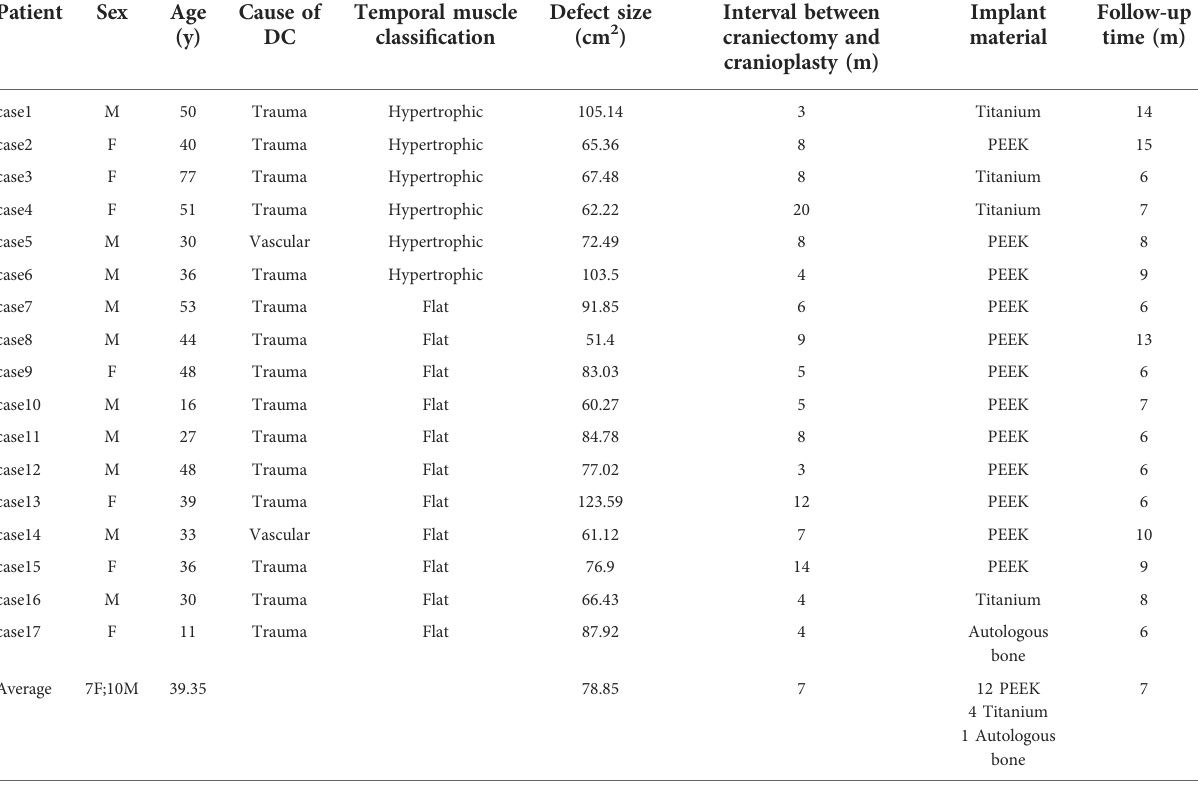
TABLE 1 Summary of patient demographics and classi fi cations of the temporal muscle. Patient